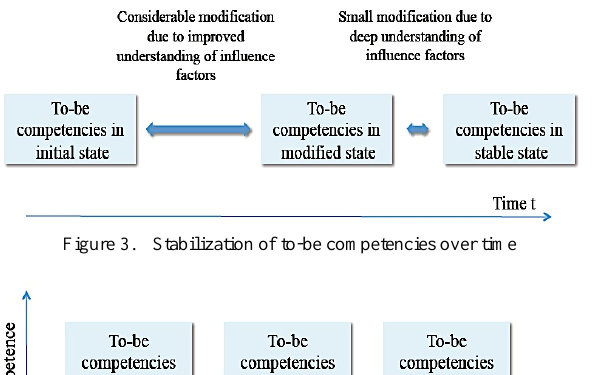
Figure 3. Stabilization of to-be competencies over time